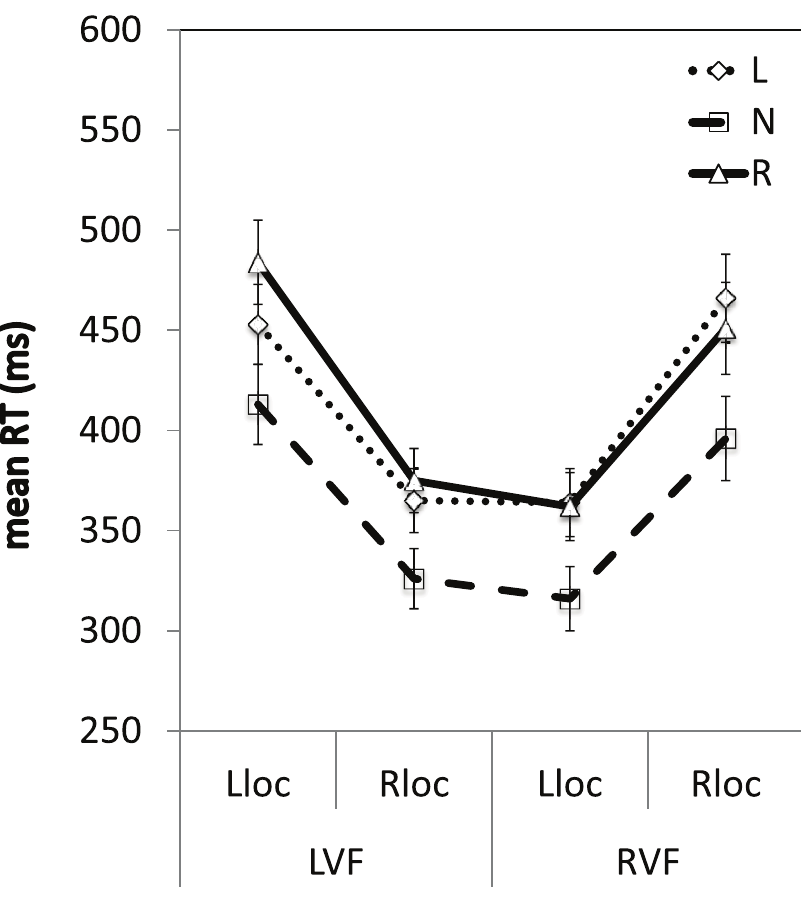
Figure 6. Reaction times across the visual field. Mean RTs (ms) are shown for validly-cued trials according to horizontal location for the three different groups. L = leftward-shifting; R = rightward-shifting, N = neutral pointing; LVF = left visual field; RVF = right visual field; Lloc = left location, Rloc = right location. Error bars indicate